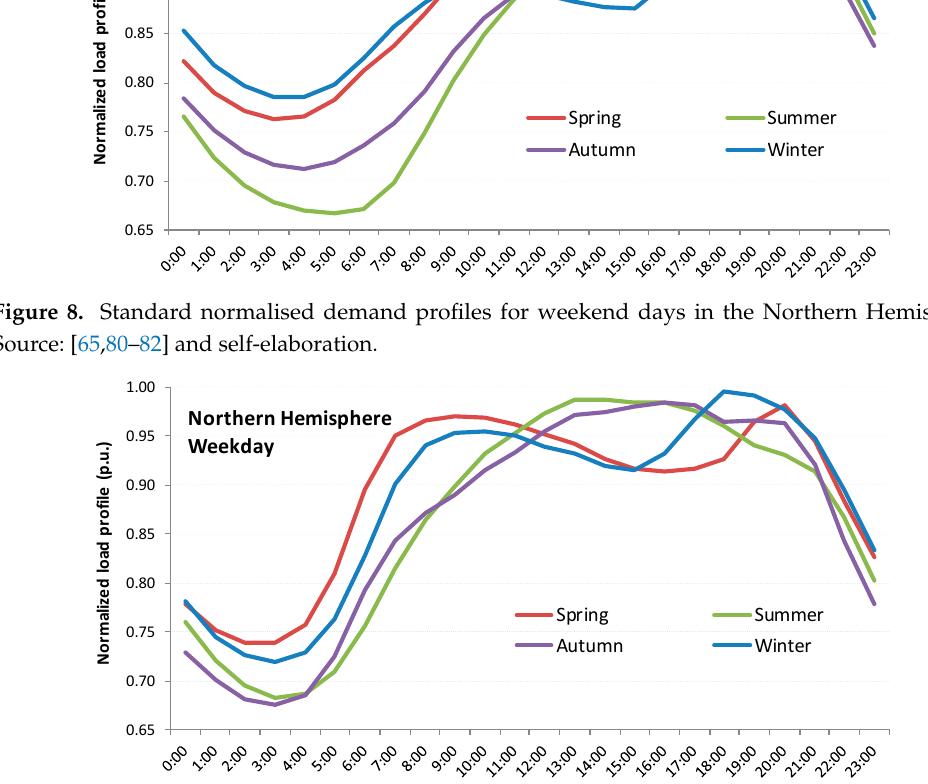
Figure 10. Standard normalised demand profiles for weekend days in the Southern Hemisphere. Source: [83,84] and self-elaboration. Figure 11. Standard normalised demand profiles for weekdays in the Southern Hemisphere. Source: [83,84] and self-elaboration.